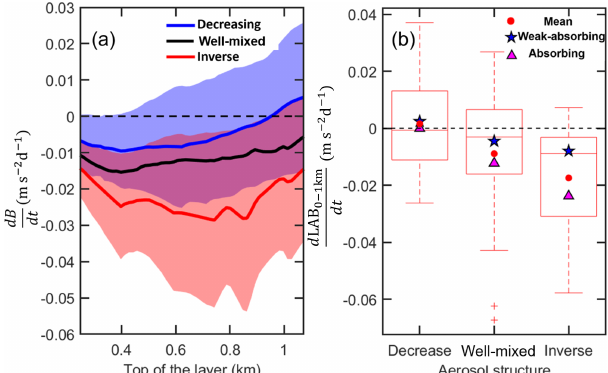
Figure 8. (a) The rate of change in buoyancy (dB / dt ) in a layer of the lowest atmosphere for decreasing (blue), well-mixed (black), and inverse (red) aerosol structures during noontime. The bottom of the layer is the surface, and the rate of change in buoyancy is sub- jected to the top of the layer. The shaded areas show the standard deviations of the rate of change in buoyancy. (b) Box-and-whisker plots showing the 10th, 25th, 50th, 75th, and 90th percentile val- ues of the rate of change in LAB 0–1km (integrated buoyancy within the lowest 1km) during noontime. Red dots indicate the mean val- ues, and blue stars and pink triangles show the means for weakly absorbing (SSA > 0 . 9) and absorbing (SSA < 0 . 85)